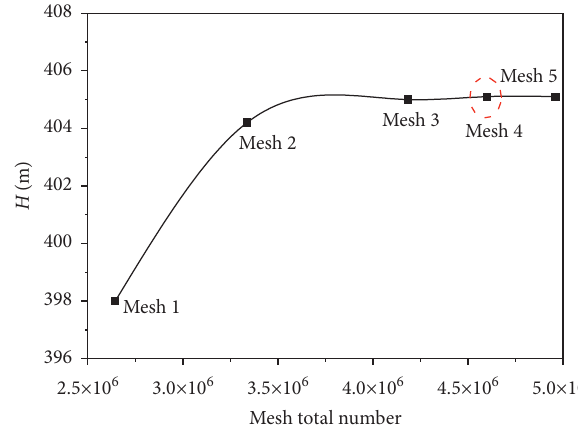
Figure 5: Head versus mesh number.